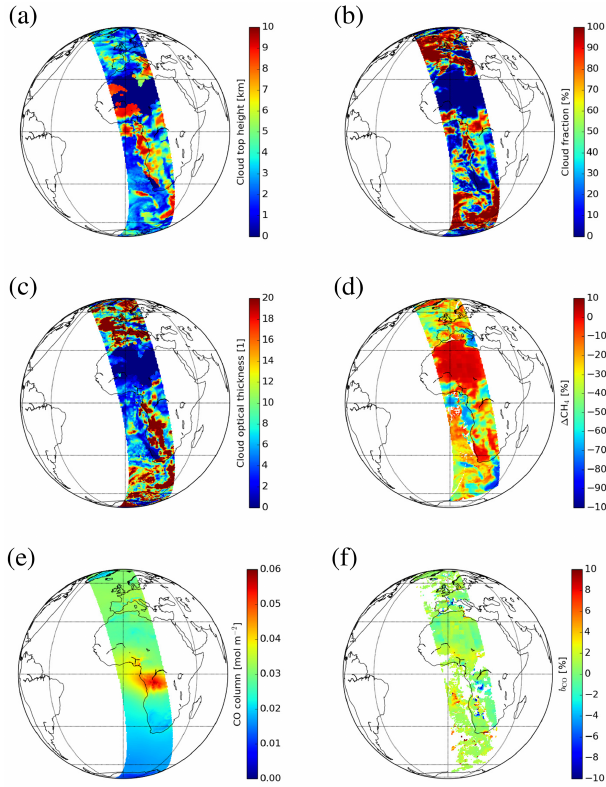
Figure 12. TROPOMI test orbit. Panel (a) cloud top height, panel (b) cloud fraction, panel (c) cloud optical depth, panel (d) methane error of non-scattering retrieval, which is used for cloud filtering, panel (e) TM4 CO total column, panel (f) CO retrieval bias.